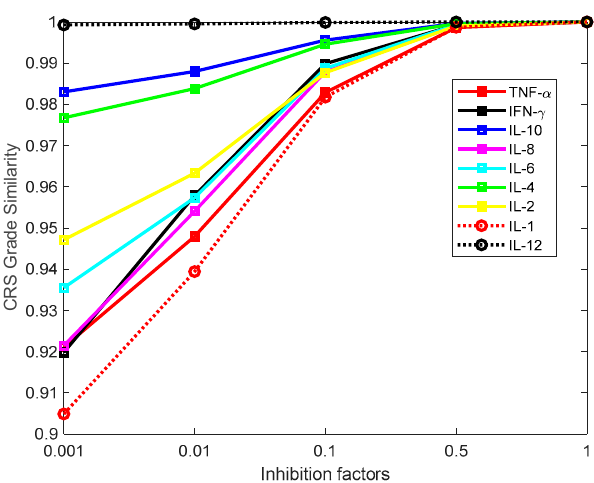
Figure 6. The CRS grade for different inhibition factors of each cytokine. A larger CRS Grade Similarity indicates the severity of CRS is more similar to the one for Grade-5 CRS.